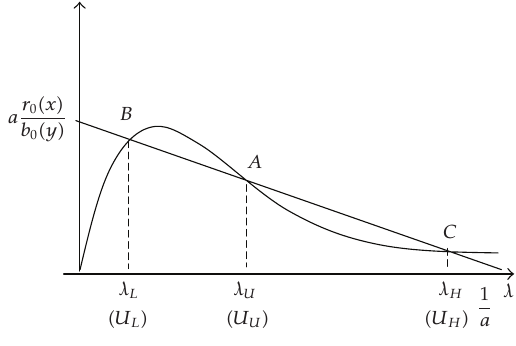
Figure 5: Unstable